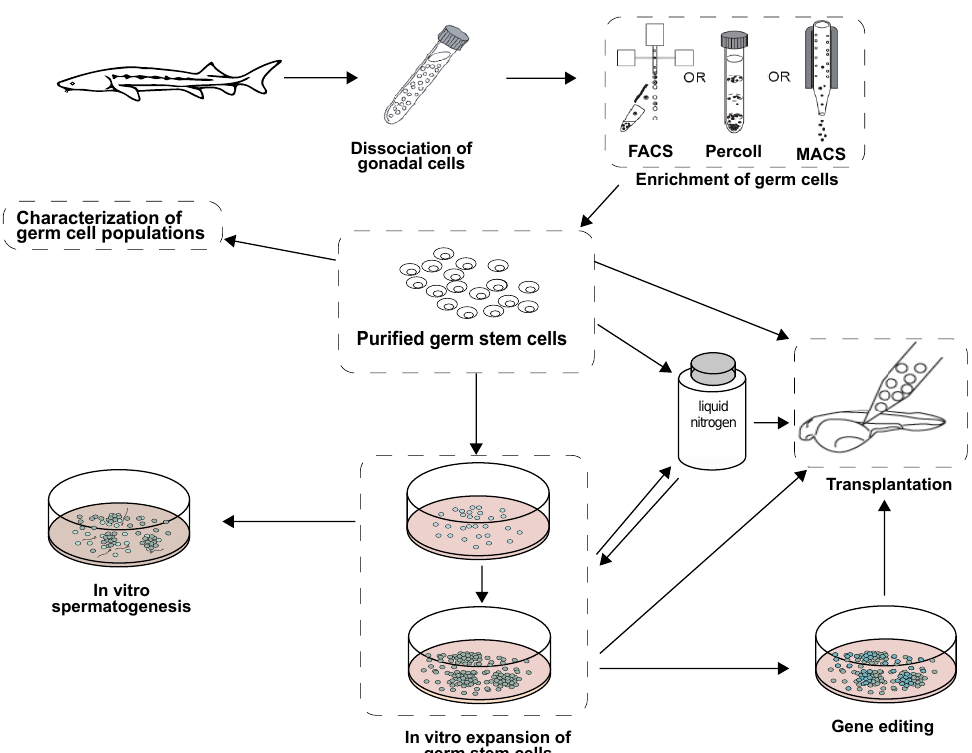
Figure 9. Potential applications of germ cell isolation and culture. Testes are removed from the fish body and dissociated, providing a cell suspension that can be sorted using fluorescence-activated cell sorting or centrifugation in a density gradient; e.g., in Percoll solution or by magnetic-activated cell sorting. The purified germ cell suspension can be characterized with respect to molecular characteristics and morphology. Purified cells may be injected into a recipient to generate germ-line chimera or amplified by in vitro culture. Cultured cells can be employed in gene editing or subjected to cryopreservation.